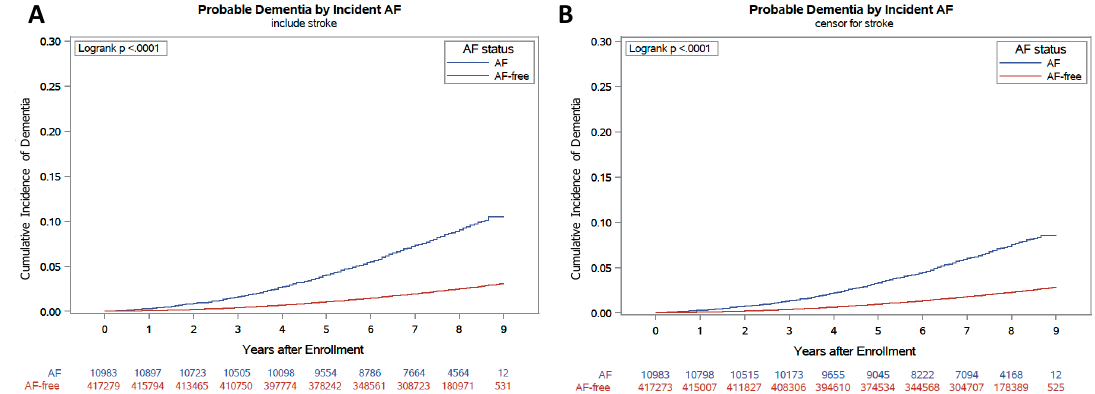
Figure 2. Cumulative incidence of dementia before ( A ) and after ( B ) censoring for stroke.